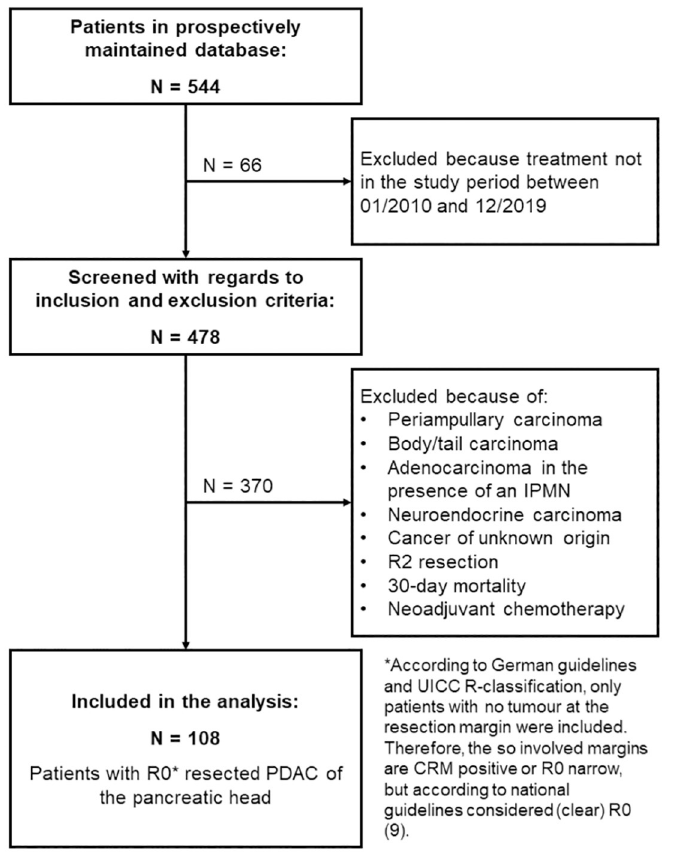
Fig 1. Flow chart depicting the screening process for inclusion of